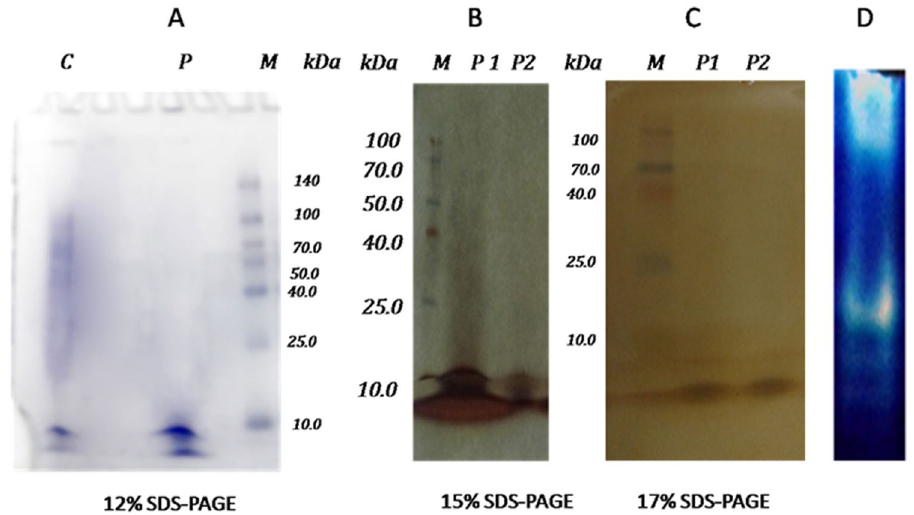
Figure 4. SDS-PAGE of the partially purified protease with keratinolytic activity from Laceyella sacchari YNDH. ( A ) SDS-PAGE (12%), cell-free supernatant (lane C), collected protease active fractions resulted from the anion exchange column (lane P), standard molecular mass marker (in the range of 10–140 kDa) (lane M), ( B ) SDS-PAGE (15%), standard molecular mass marker (in the range of 10–100 kDa) (lane M), collected protease active fractions resulted from the anion exchange column (lane p1, p2 repeats), ( C ) SDS-PAGE (17%), standard molecular mass marker (in the range of 10–100 kDa) (lane M), collected protease active fractions resulted from the anion exchange column (lane p1, p2 repeats), ( D ) Activity staining (zymogram) for a partially purified protease with keratinolytic activity from Laceyella sacchari YNDH (lane D).